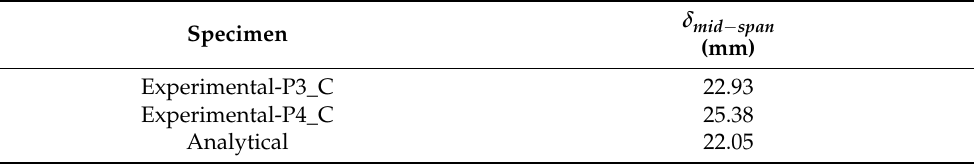
Table 13. Comparison between instantaneous deflection obtained from the experimental results and that obtained from analytical